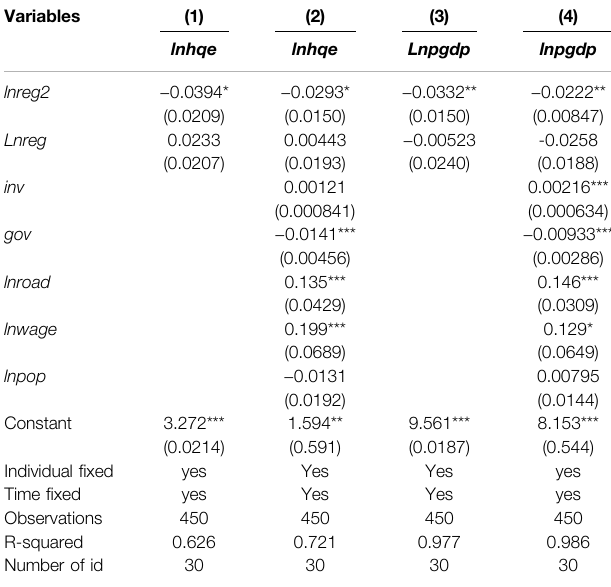
TABLE 6 | The in fl uence of environmental regulation on economic development.